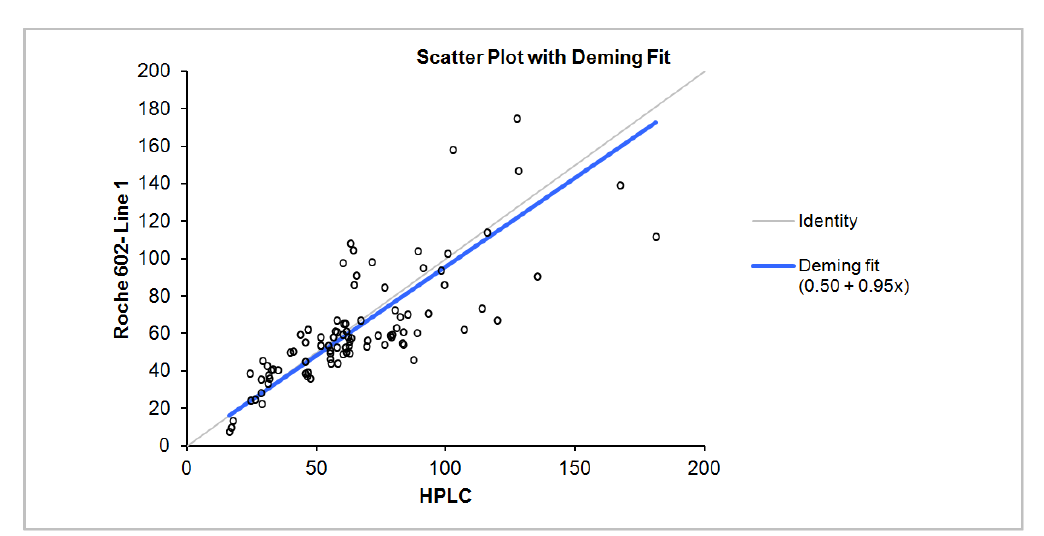
Figure 1. Deming regression of total 25(OH) D comparison: Chromsystems HPLC as the reference method vs. Roche Diagnostics Vitamin D total method on the Cobas